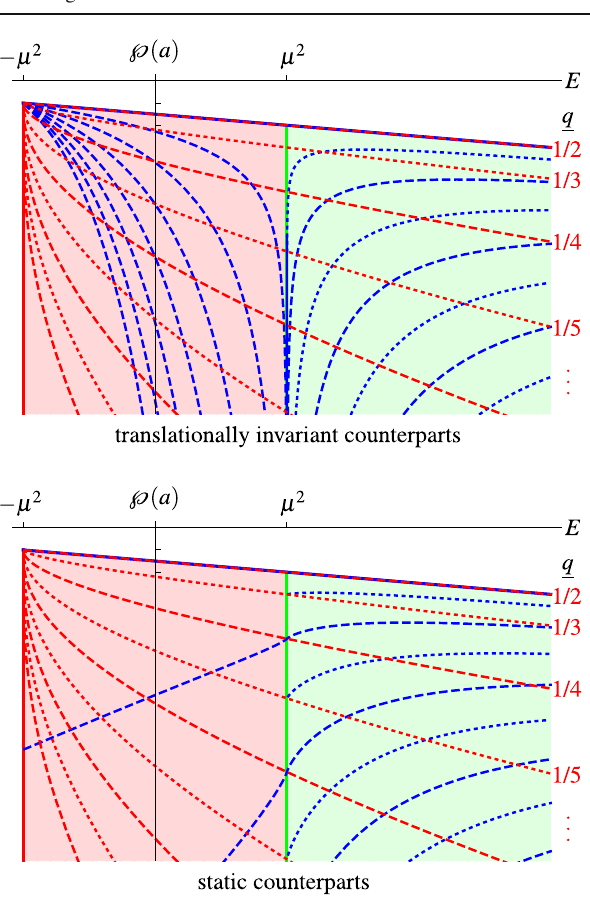
Fig. 5 The trajectories in the moduli space where the dispersion rela- tion can be specified